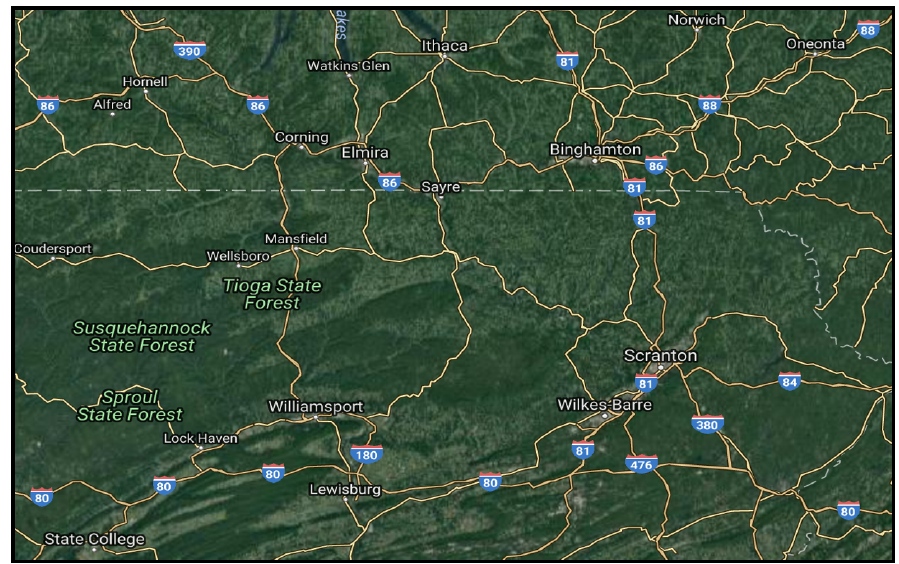
Figure 4. In domain 3, the latitude ranges from 40 to 42.67 ◦ N. The longitude ranges from − 78 to − 75.17 ◦ W. The figure shows the satellite view of the domain with major roads, cities and landmarks. Table 1. The table showing the input data sources for each of the three scenarios (DEFAULT, HR and